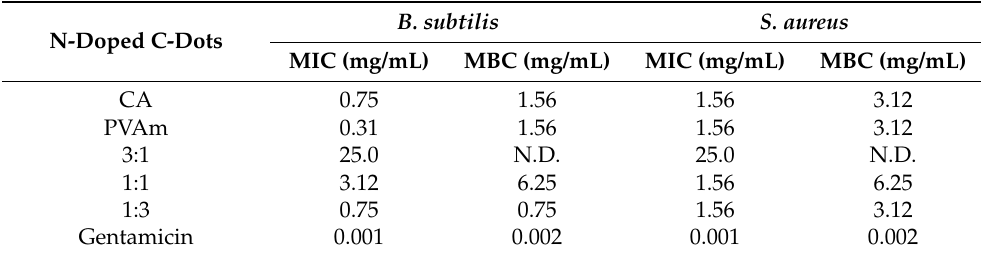
Table 3. Minimum inhibition concentration (MIC) and minimum bactericidal concentration (MBC) of CA, PVAm, and N-doped C-dots prepared at 3:1, 1:1, and 1:3 ratios against B. subtilis and S. aureus Gram-positive bacteria according to microtiter dilution assay. Gentamicin was used as a control. N-Doped C-Dots